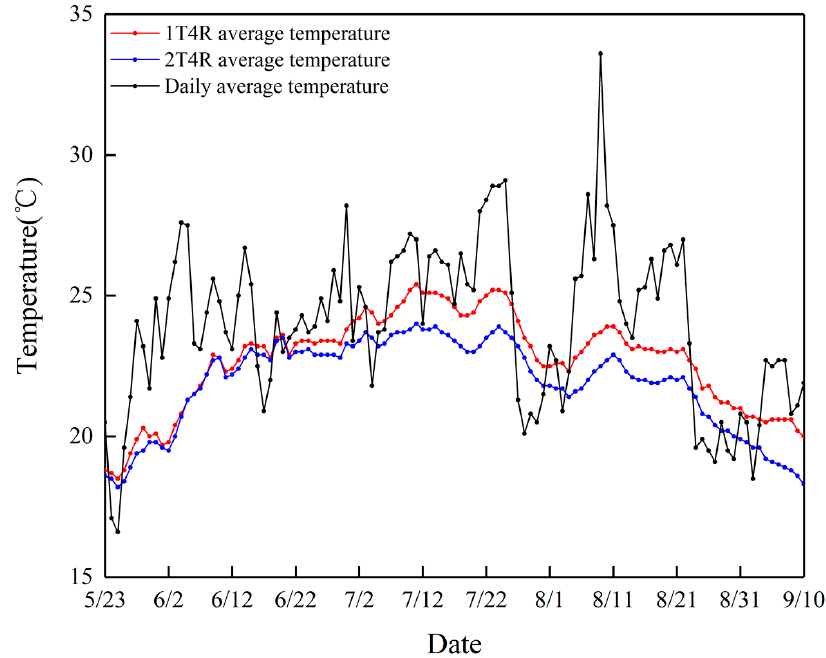
Figure 6. Average temperature of soil compared to air temperature in different drip irrigation treatment conditions in 2018a.